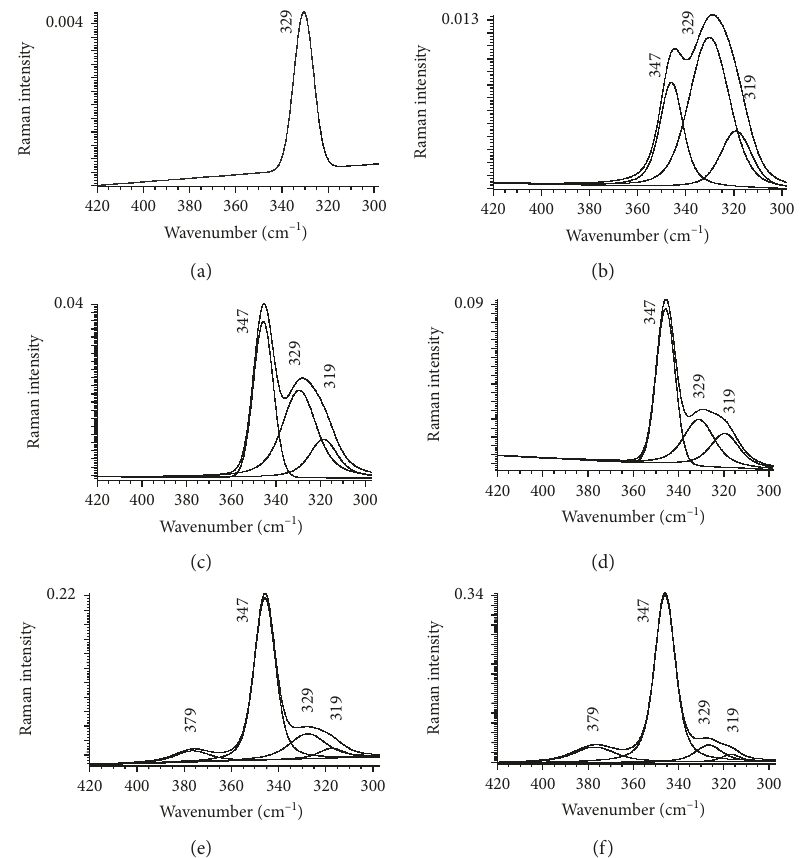
Figure 4: Raman spectra of GaCl 3 -FA solutions at different molalities at the region characteristic of the metal-chloride vibrations: (a) 0.1; (b) 0.3; (c) 0.5; (d) 0.7; (e) 1.0; (f) 1.5.